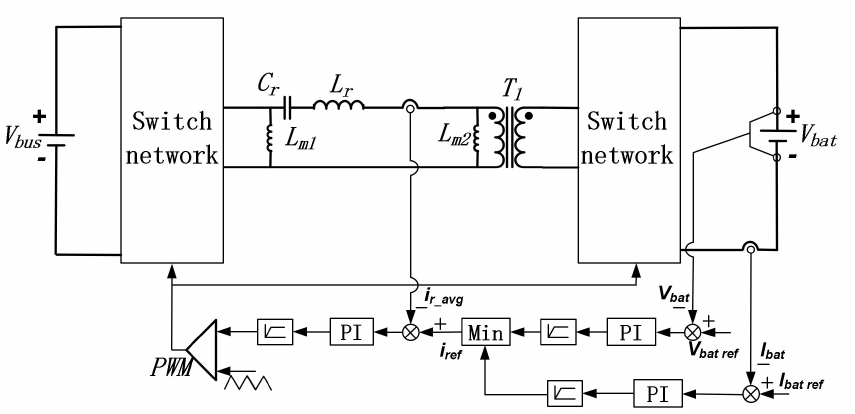
Figure 12. Control block diagram of the converter under the charging model.